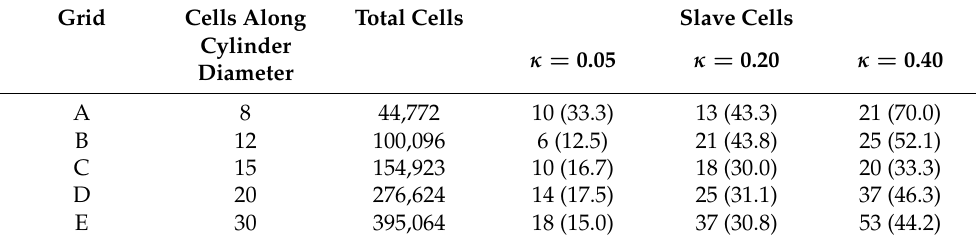
Table 4. Grid sizes used for the flow around a cylinder